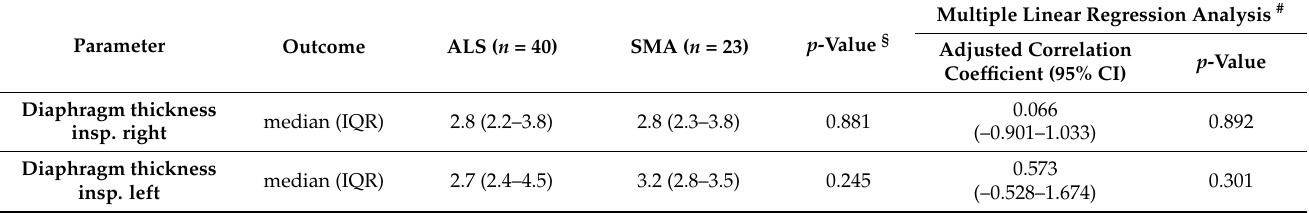
Multiple Linear Regression Analysis # Adjusted Correlation p -Value Coefficient (95% CI)